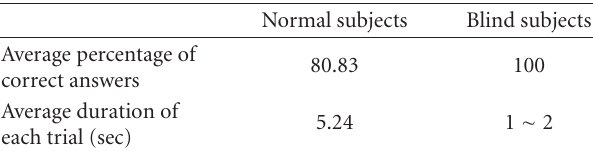
Figure 5: Braille patterns for the experiment. Table 1: Experimental